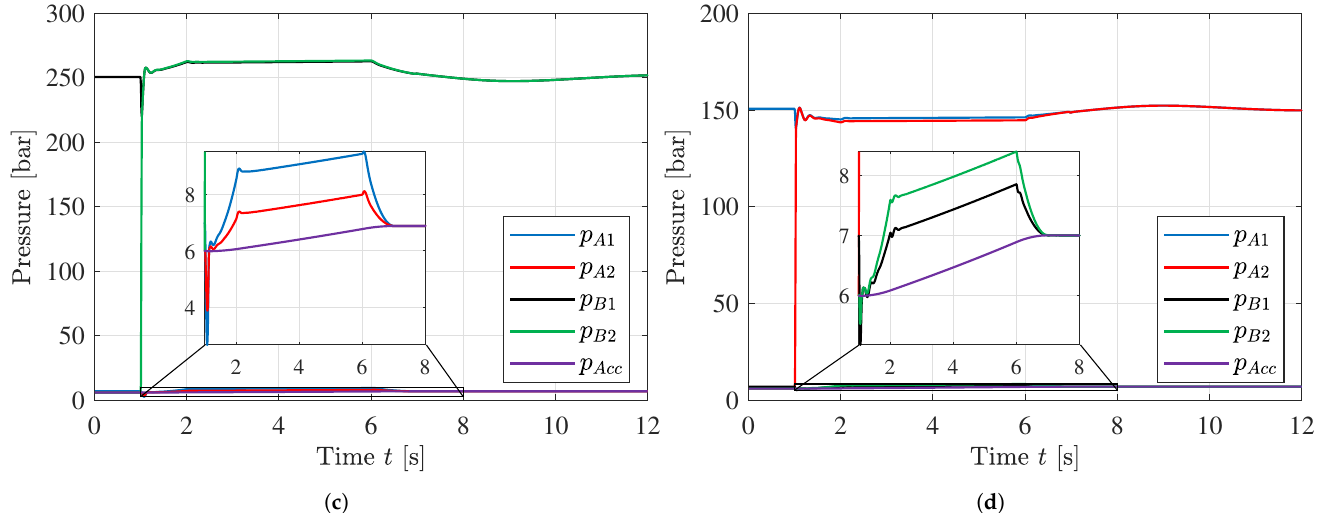
Figure 18. System pressures for all four quadrants during motion. ( a ) Quadrant 2; ( b ) Quadrant 1; ( c ) Quadrant 3; ( d ) Quadrant 4.